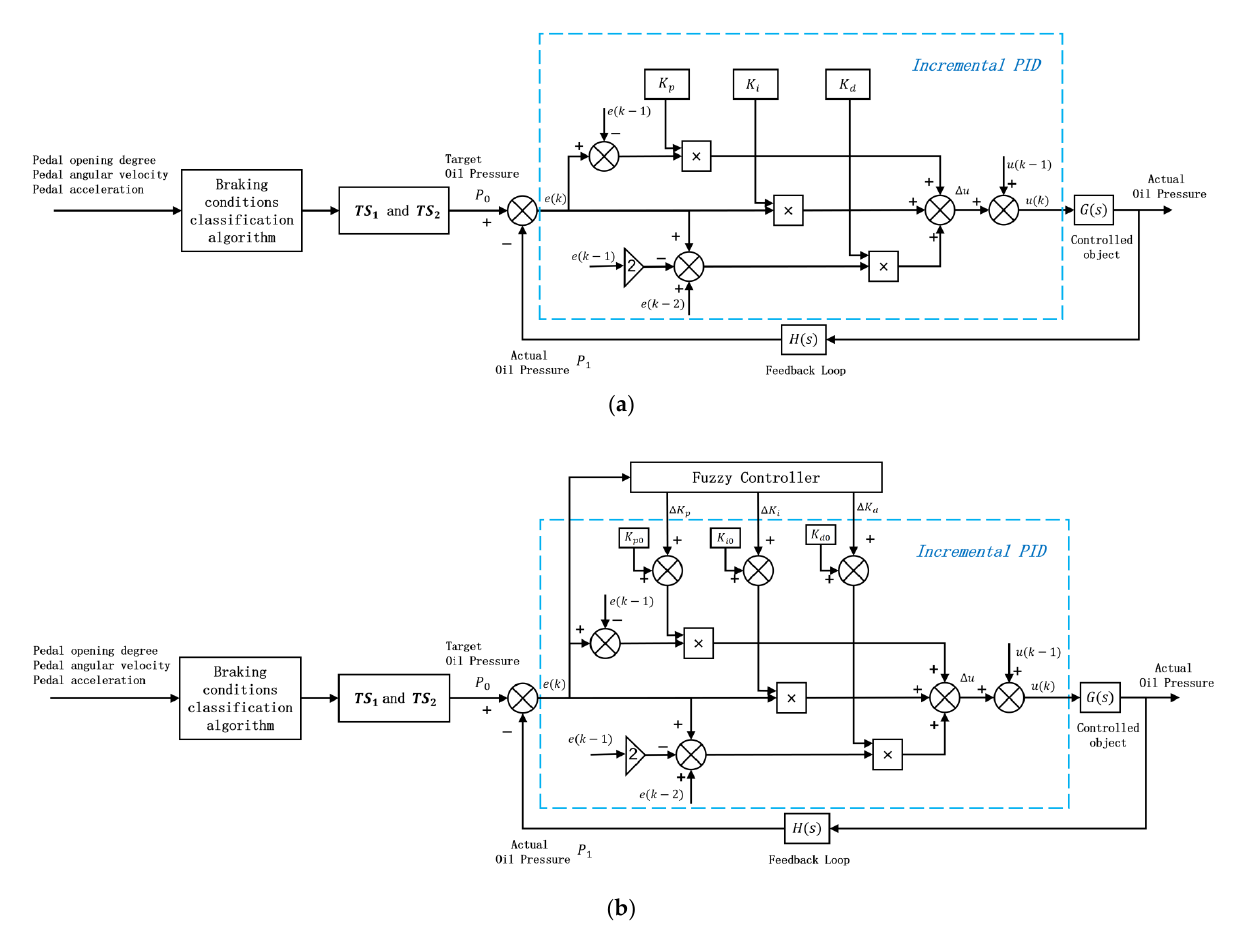
Figure 12. Block diagram of the target oil pressure following control: ( a ) Traditional PID controller. ( b ) Fuzzy PID controller.